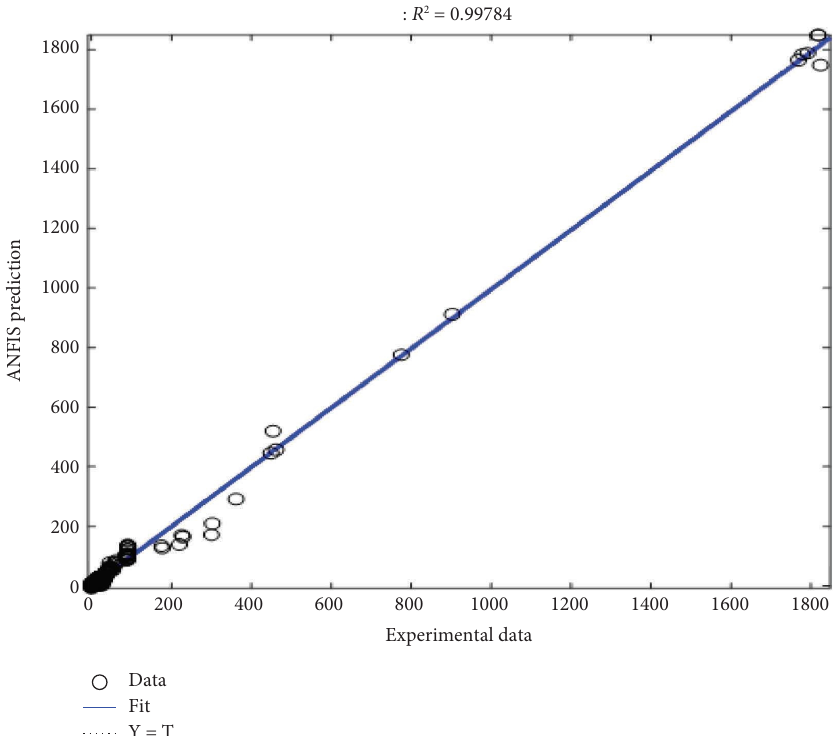
Figure 7: Efectiveness of the ANFIS prediction (parity